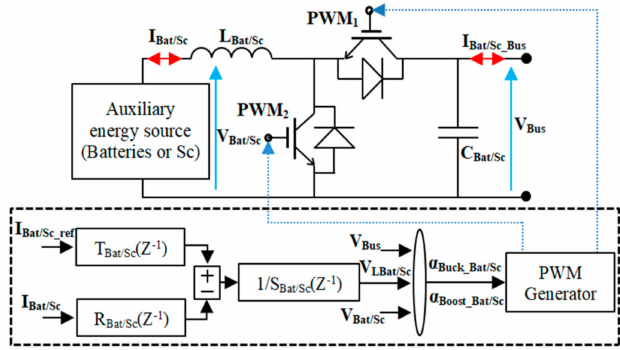
Figure 12. Batteries and Sc currents control